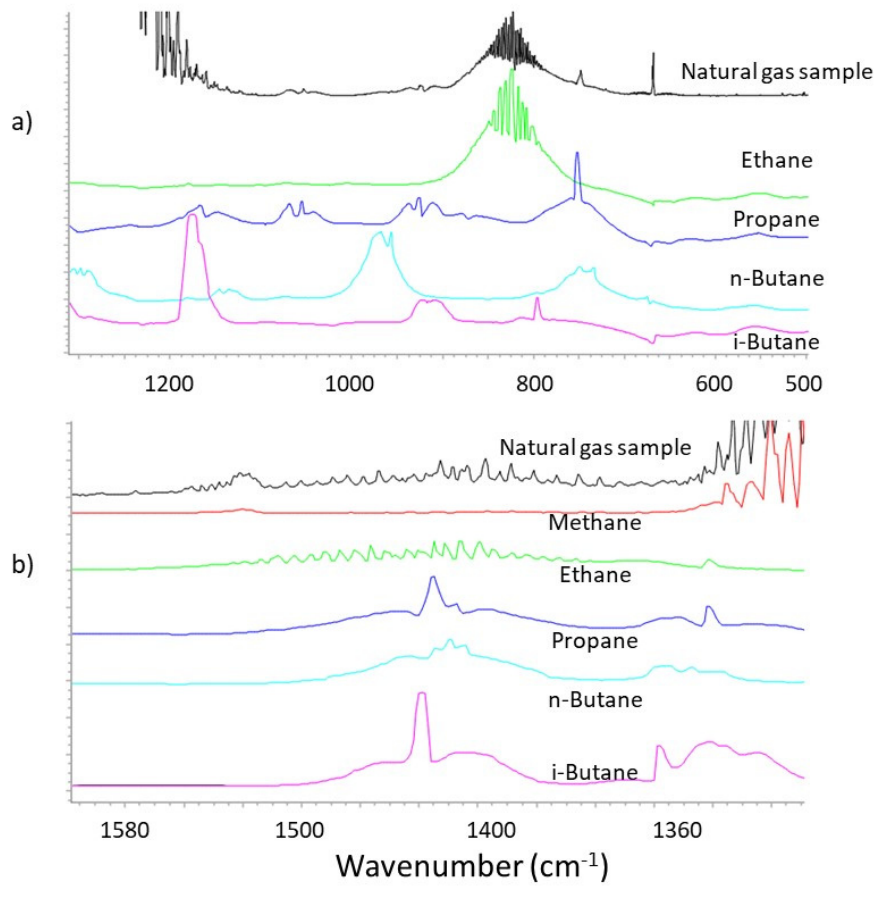
Figure 9. Close-up view of the 1300–500 cm − 1 ( a ) and 1600–1340 cm − 1 ( b ) regions of a LNG spectrum (depicted in Figure 8).